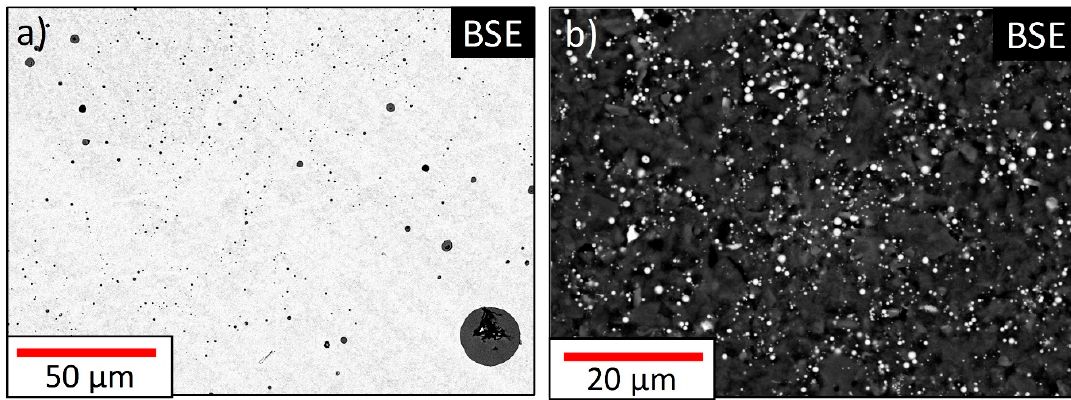
Figure 5. BSE image of ( a ) cross-section and ( b ) polycarbonate filter of Sample 1.